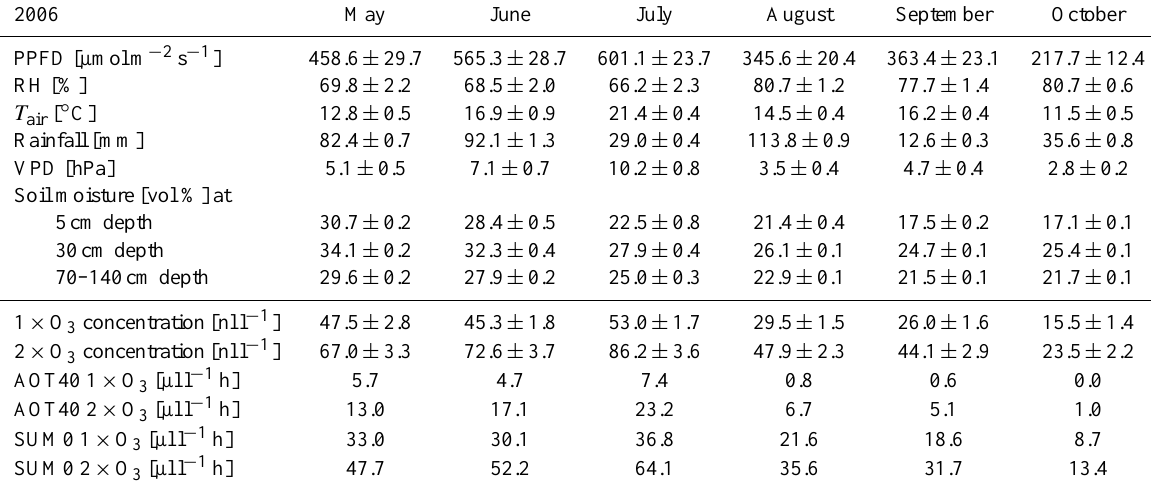
Table 1. Weather conditions and O 3 levels at the study site “Kranzberger Forst” during the growing season of 2006. Monthly sum of precipitation and average of daytime photosynthetic photon flux density (PPFD), relative air humidity (RH), air temperature ( T air ) , vapor pressure deficit (VPD) and soil moisture ( ± SE, n = 30 to 31). Ozone levels as monthly means ± SE ( n = 30 to 31), AOT40 (i.e.